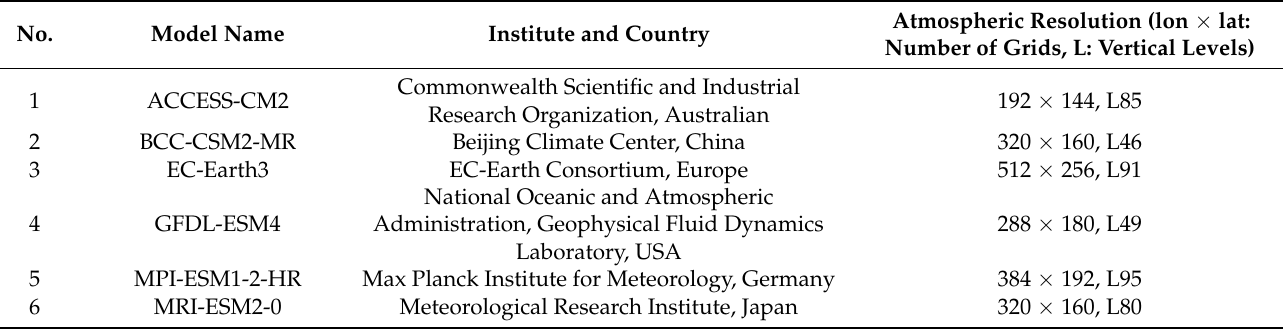
Table 1. Information on the six global climate models (GCMs) selected in our